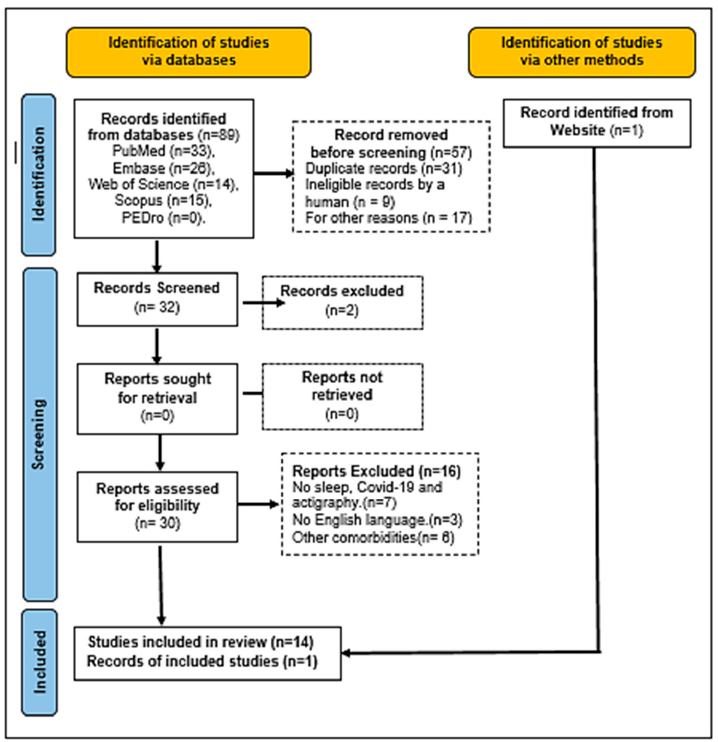
Figure 2. PRISMA 2020 flowchart of bibliographic research and the various steps in the selection of the articles.